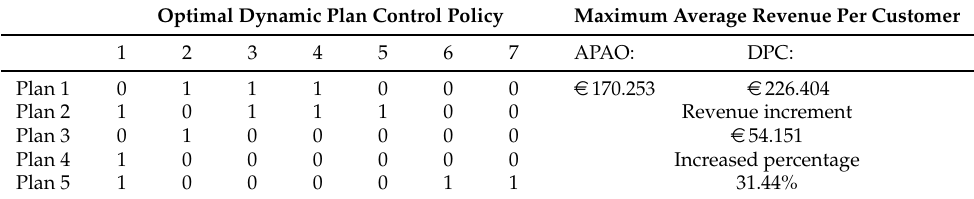
Table 5. Results of the base case. APAO, all plans always open; DPC, dynamic plan